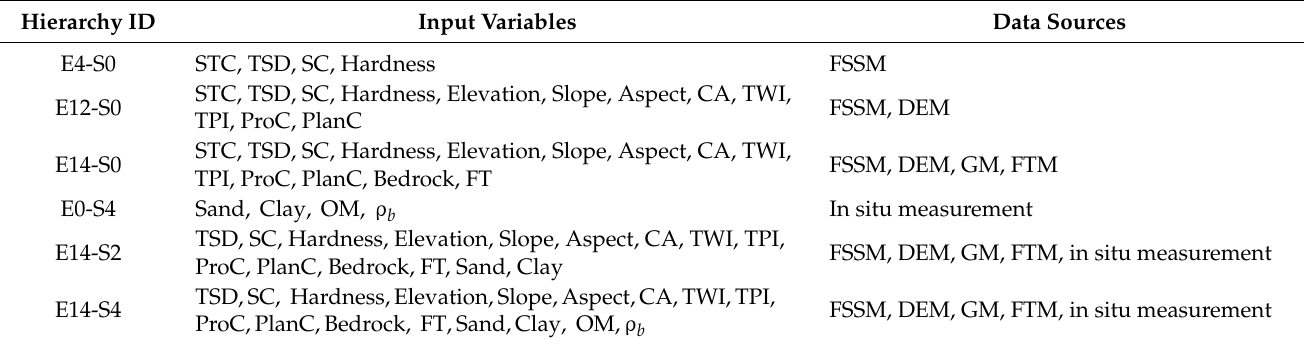
Table 2. Six predictor set hierarchies, the input variables of each hierarchy, and their data